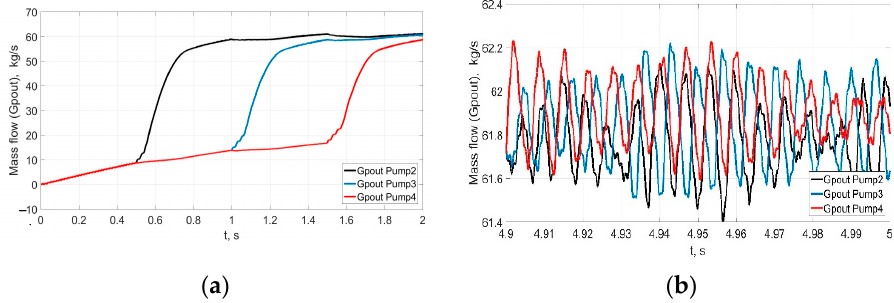
Figure 13. Mass flows of LNG of HP Booster Pumps: ( a ) the beginning of the simulation time; ( b ) the end of the simulation.